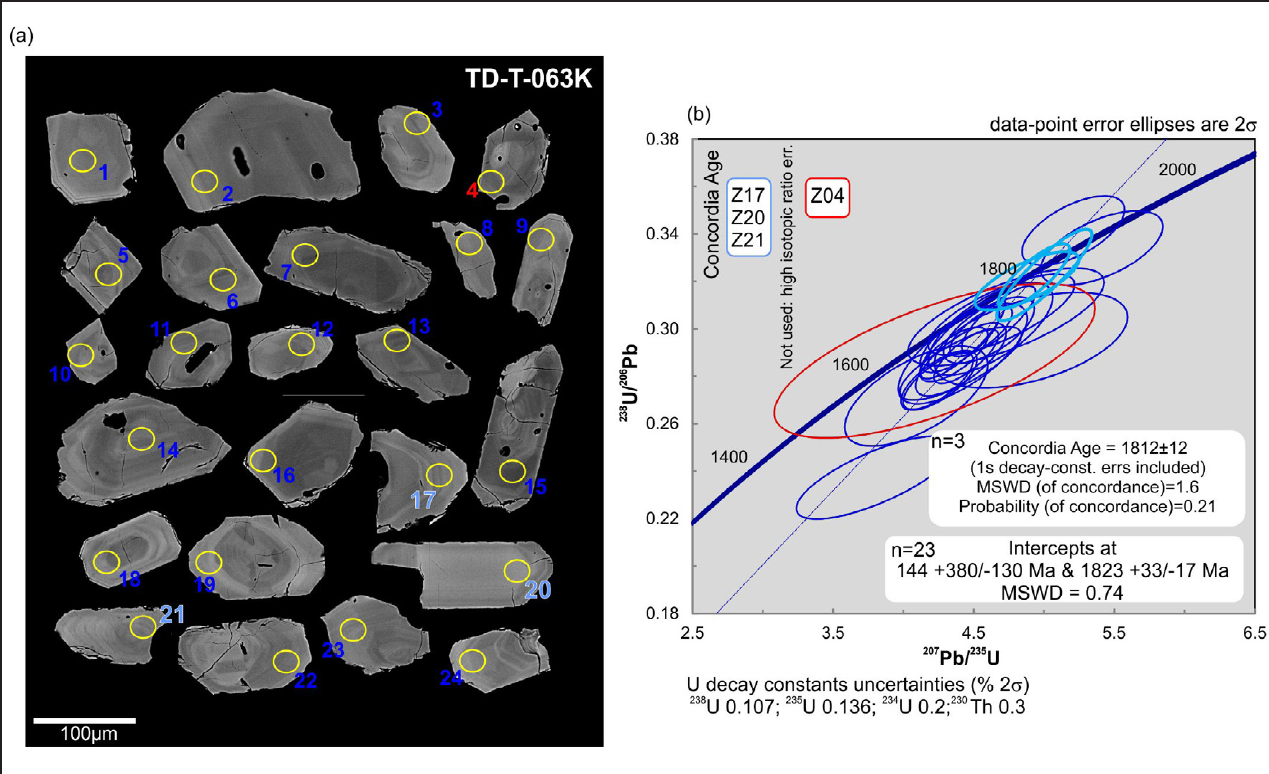
FIGURE 13 - (a) BSE image of zircons of a volcaniclastic from the Colíder Group (sample TD-T-063K) showing their morphological features, location and ID of pits; and (b) U-Pb upper intercept age in the concordia diagram. The blue color represent the spots results used in the upper intercept and concordia age calculation, conversely, the red color represent those not